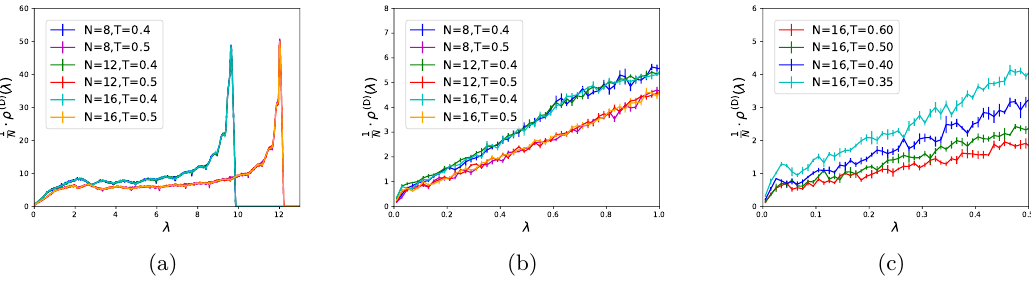
Figure 15. The density of Dirac eigenvalues, ρ (D) ( λ ) , divided by N , for N = 8 , 12 , and 16 , n t = 24 , and T = 0 . 4 and 0 . 5 , i.e. in the deconfined phase, with 500 configurations (5000 sets of eigenvalues) for each. Error bars are estimated by using 5-bin Jackknife with bin width 0 . 02 . We see in all cases that ρ (D) ( λ ) → 0 as λ → 0 , indicating h ¯ ψψ i = 0 and hence that chiral symmetry is preserved, as expected. (b) Close-up of (a), showing that the slope near λ = 0 increases as T increases. (c) The same, but for T = 0 . 35 , 0 . 40 , 0 . 50 , and 0 . 60 , showing again that the slope near λ = 0 increases as T increases.